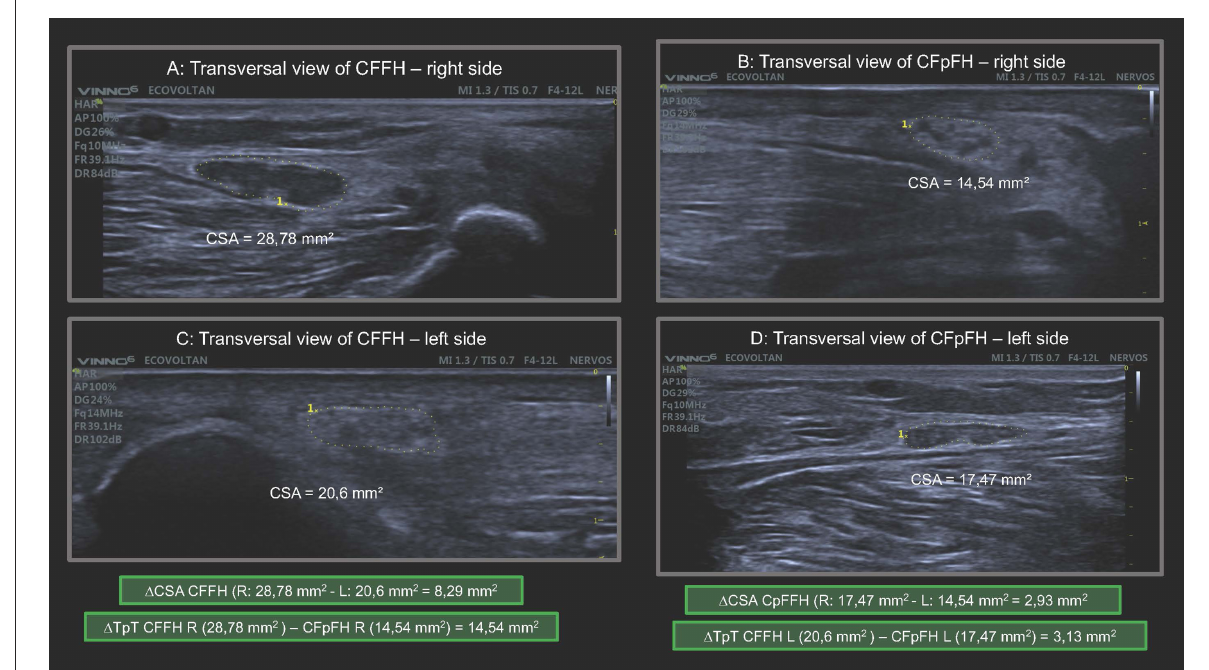
FIGURE6 Transversal view of common fibular nerve on the right and left sides in the same HD patient demonstrating enlargement of peripheral nerve, asymmetry ( 1 CSA) and focality ( 1 TpT) major than normal references values. CSA, cross-sectional área; CFFH, common fibular nerve at fibular head; CFpFH, common fibular nerve proximal at fibular head; R, right; L, left; 1 CSA, asymmetry; 1 TpT, focality. In the green frame we highlight the calculation of 1 CSA and 1 TpT.